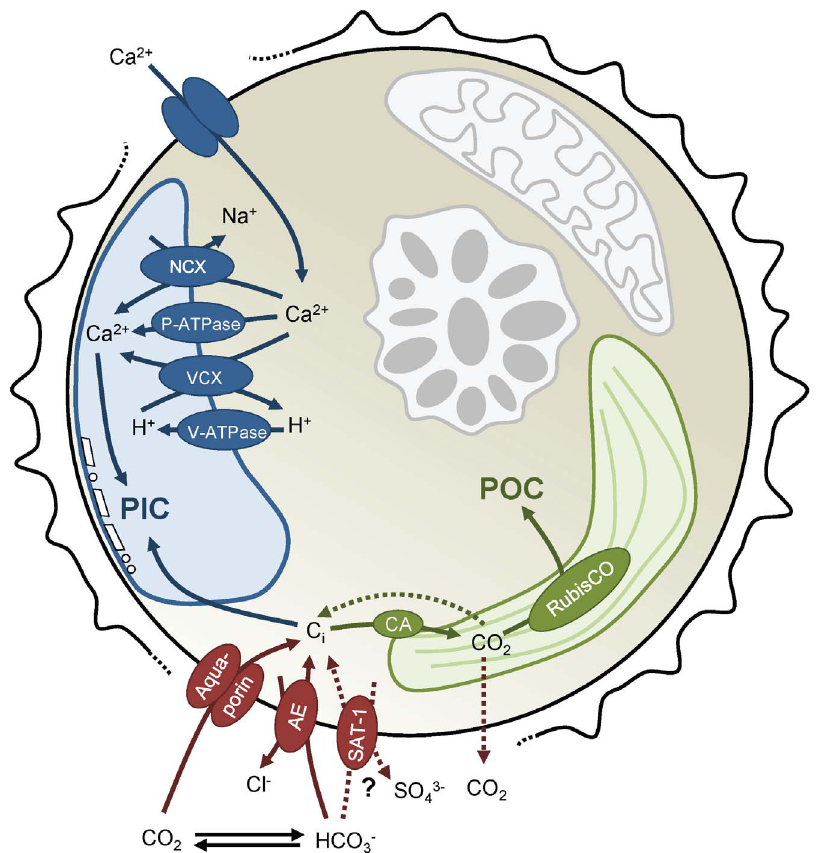
Figure 5. Conceptual model of regulated proteins in a T.heimii cell . The regulated proteins involved in ion transport and C i acquisition are shown on their putative locations [39,49,57] . Proteins involved in vacuolar Ca 2 + and H + transport include P-type Ca 2 + ATPases (P-ATPase), Ca 2 + /Na + exchangers (NCX), Ca 2 + /H + antiporters (VCX), and vacuolar H + ATPases (V-ATPase). Active uptake of HCO 3 2 may occur via a SLC4 family anion exchanger (AE) or an SLC26 family SO 43 2 / HCO 3 2 / C 2 O 42 2 anion exchanger (SAT-1). Carbonic anhydrases (CA) are located intracellularly or extracellularly and enhance the interconversion between CO 2 and HCO 3 2 . Figure S1 Population growth dynamics. Population densi- ties in each replicate over time in the (A) 150 m atm, (B) 380 m atm, (C) 750 m atm, and (D) 1400 m atm CO 2 treatments. Lines indicate Figure S2 Number of expressed genes. Venn diagram of the number of expressed genes in the 150 m atm, 380 m atm, and 1400 m atm CO 2 treatments.